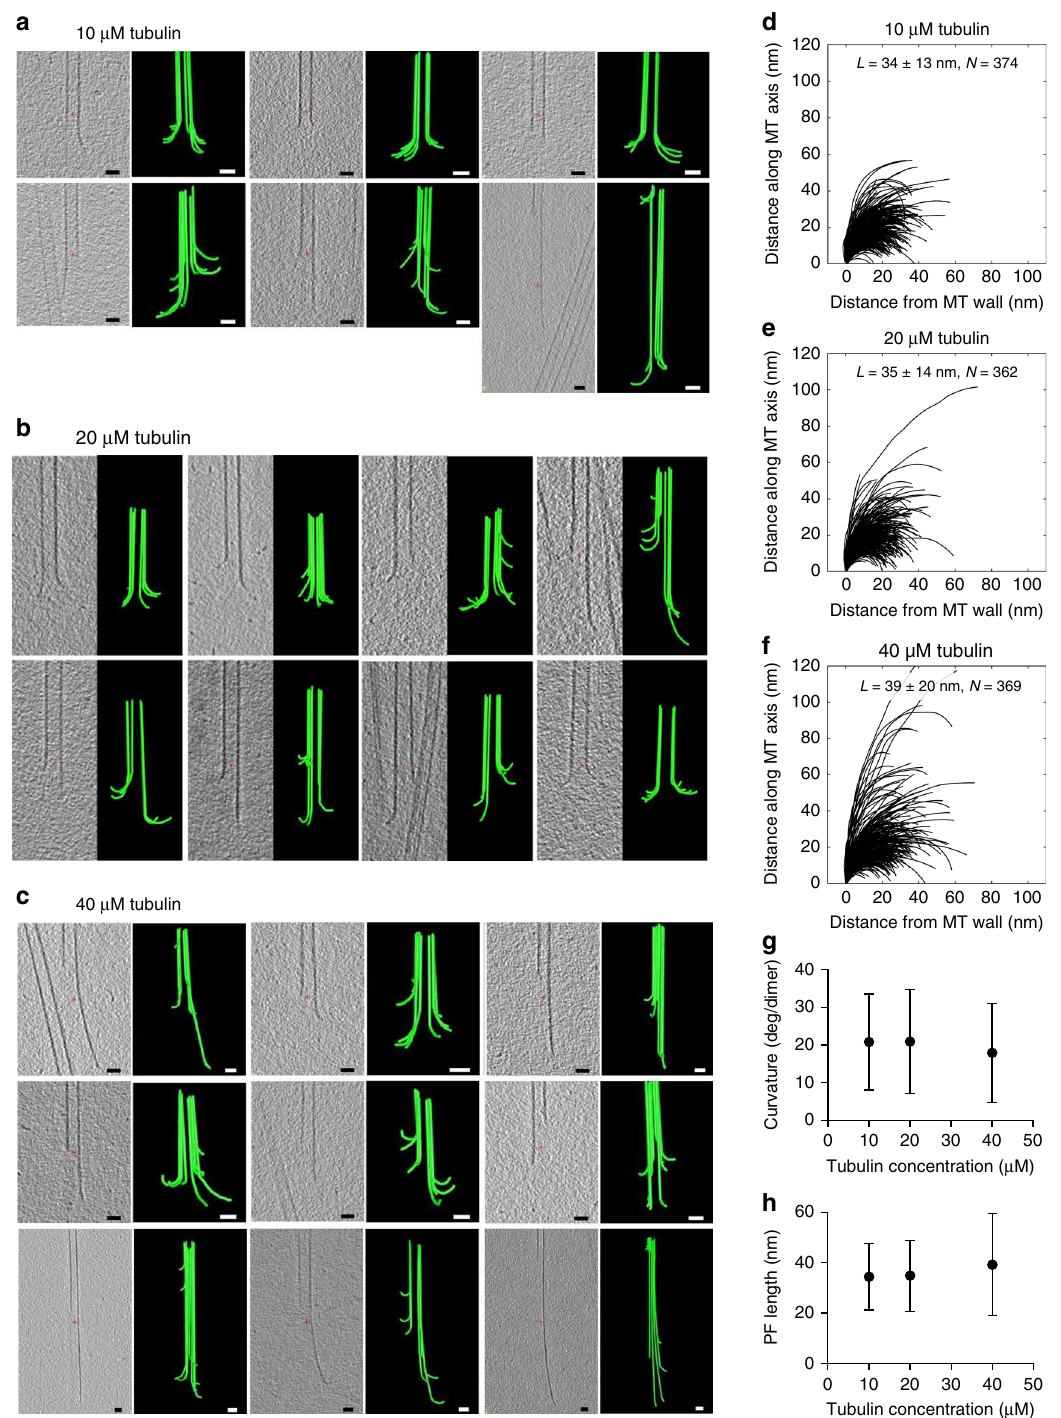
Fig. 5 Quantitative analysis of PF tip shapes on MTs grown at three tubulin concentrations. a – c Tomographic slices and models of representative MTs elongating from axonemal doublet MTs at three concentrations of free tubulin. Red crosses mark the origins of the coordinate systems used. Bars, 25 nm. d – f LOESS-smoothed traces of PFs from 136 growing MTs (49 MTs at 10 μ M, 37 MTs at 20 μ M, and 50 MTs at 40 μ M). Ns numbers of PFs traced. Raw tracing coordinates are provided as a Source Data fi le. g Average curvatures of PFs as a function of free tubulin concentration. Means ± s.d. h Average curled PF lengths as a function of free tubulin concentration. Means ± s.d. Source data, describing PF curvatures and lengths, are provided as a Source Data fi